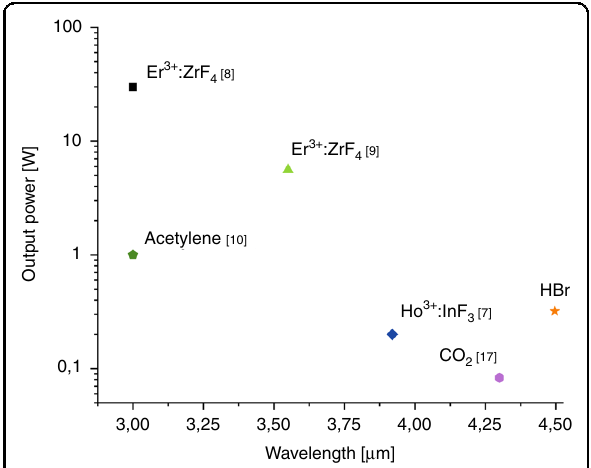
Fig. 1 Continuous wave mid-IR fi ber lasers. Summary of the state- of-art continuous wave mid-IR fi ber lasers in terms of output and lasing